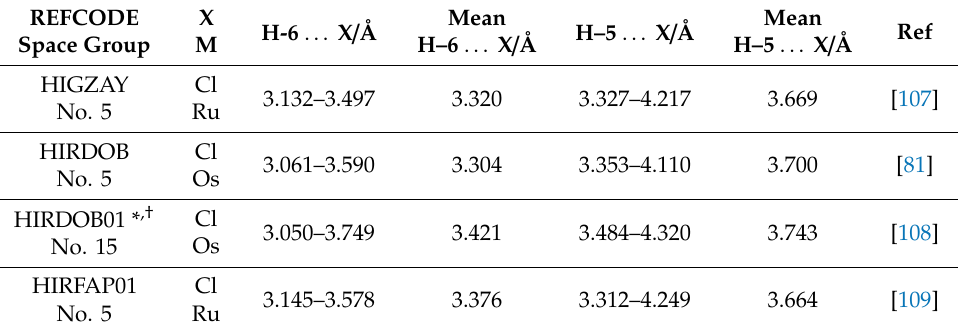
Figure 3. The Structure Type 1 halide ions are located in a sheet of [M(bpy) 3 ] n + cations. ( a ) The halogen and metal centres in the sheet can define a plane ([Ni(bpy) 3 ]Cl 2 · 5.5H 2 O, Refcode EGOVEB) [90] viewed along a or ( b ) the sheet may be ru ffl ed ([Ni(bpy) 3 ] 2 [Ag 3 Mo 3 S 12 ]Cl · 2DMF · 2H 2 O, Refcode TIMSOY) [93] viewed along b ). Structure Type 1 halogen shown in space-filling mode, metal atoms and other anions and solvent molecules between the cation sheets as ball and stick representations, metal atoms in orange and all other elements CPK colours. Hydrogen atoms are only shown for the [M(bpy) 3 ] n + cations. Table 4. Structure Type 2 sub-motifs with twelve C–H ... X interactions with two